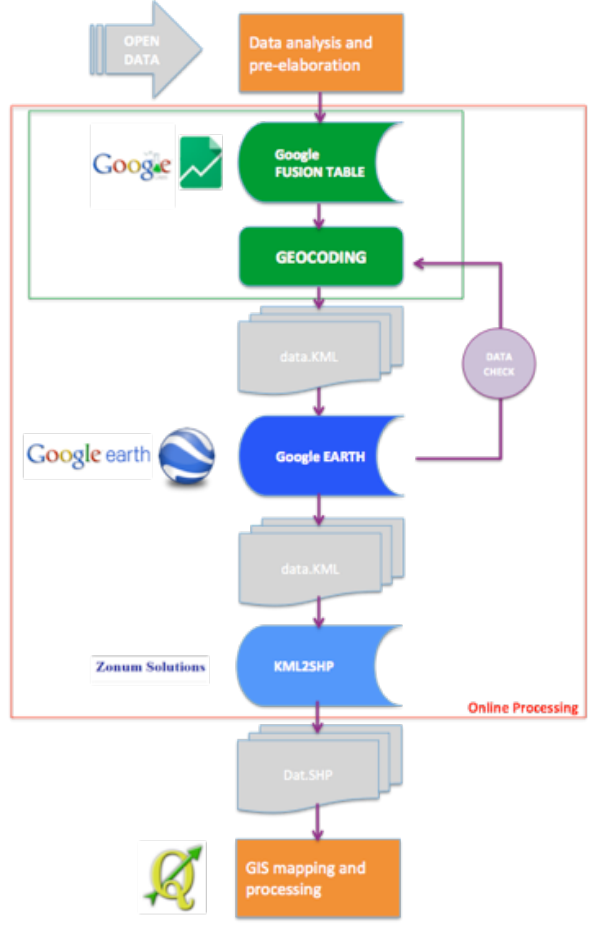
Figure 2. Territorialisation procedure flow chart.